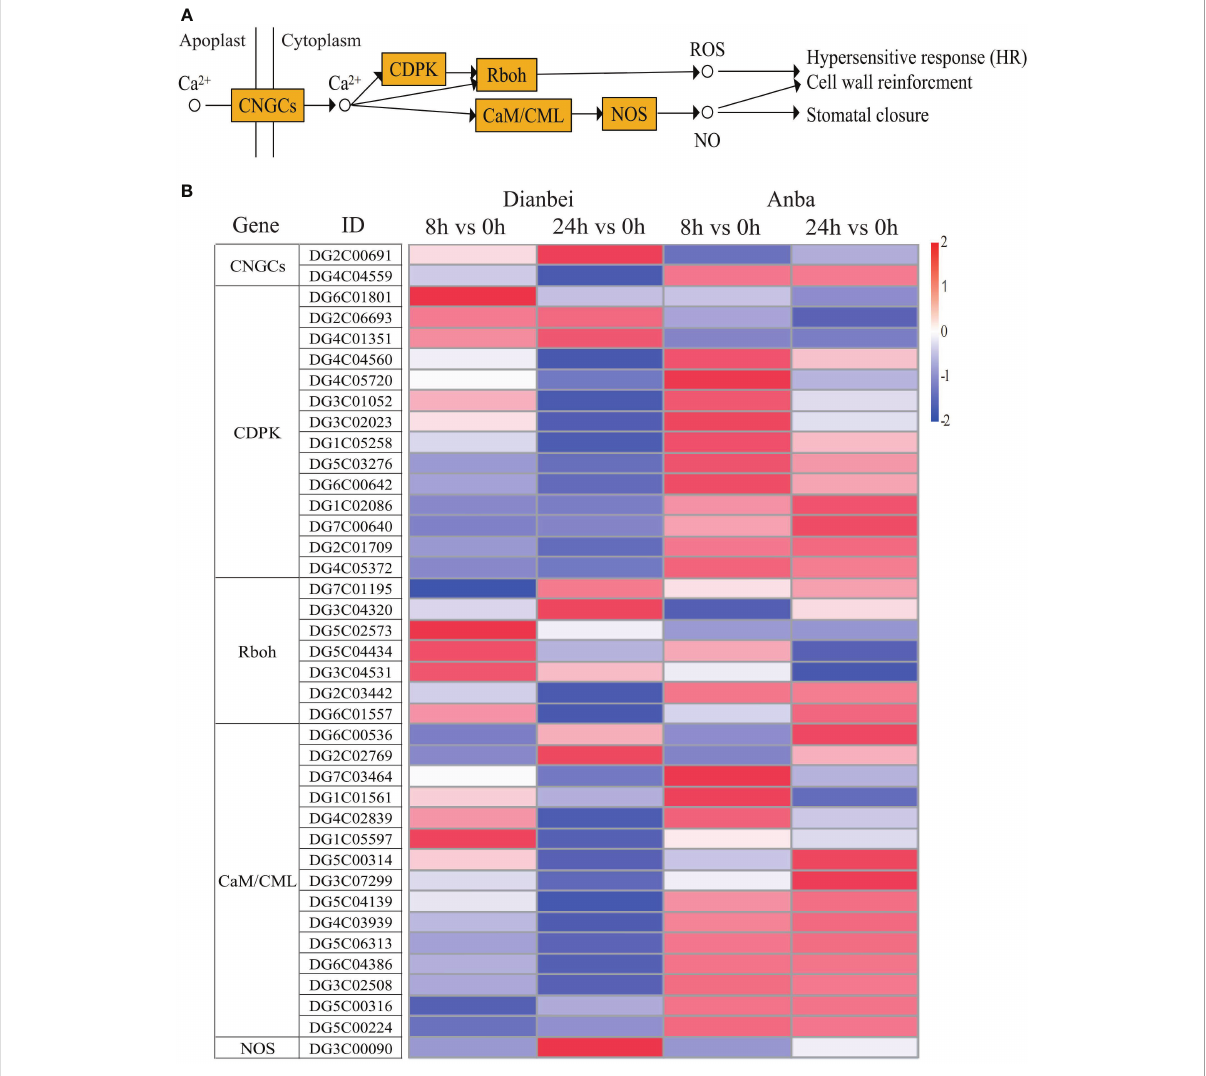
FIGURE 8 Ca 2+ signal transduction pathway. (A) Schematic diagram of Ca 2+ signaling pathway. (B) Heatmap of DEGs involved in Ca 2+ signaling pathway. The y-axis shows the cluster dendrogram of DEGs, while the x-axis shows the sample